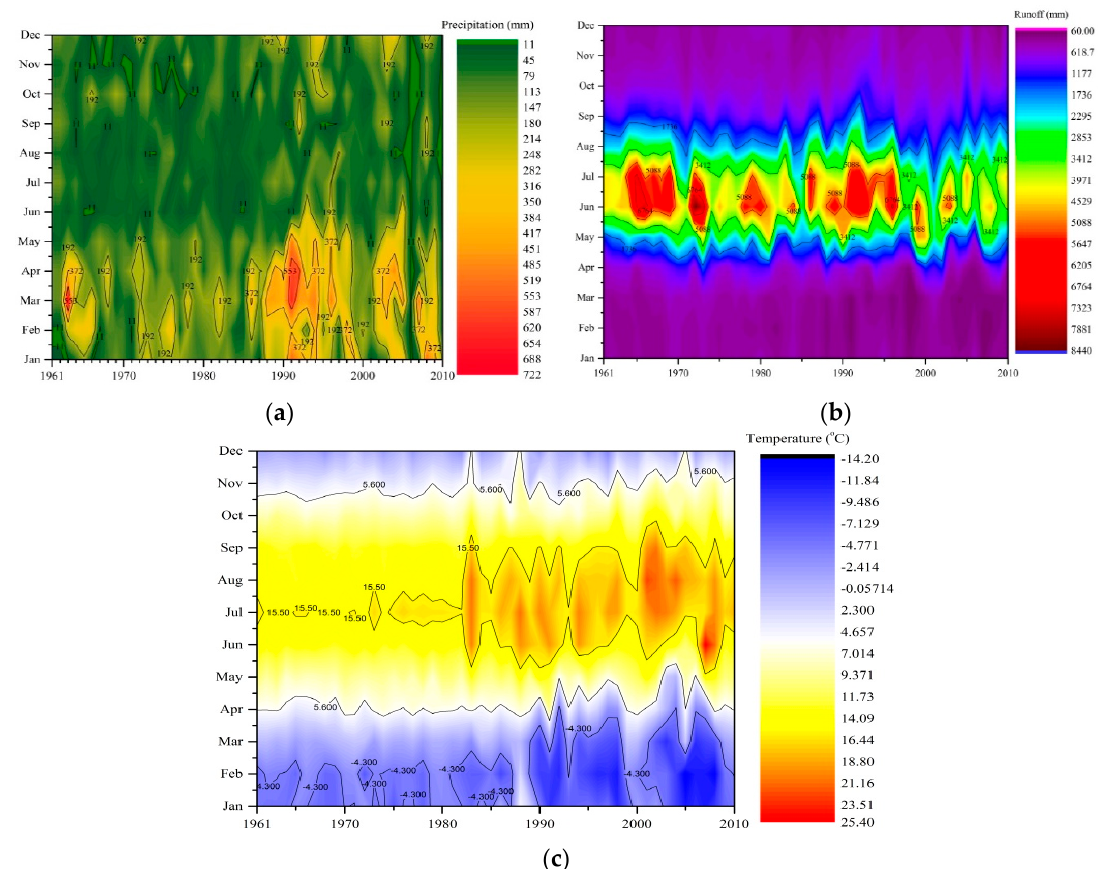
Figure 10. Iso-plot of precipitation, runoff and temperature of Zone I. ( a ) precipitation ( b ) runoff ( c ) temperature.